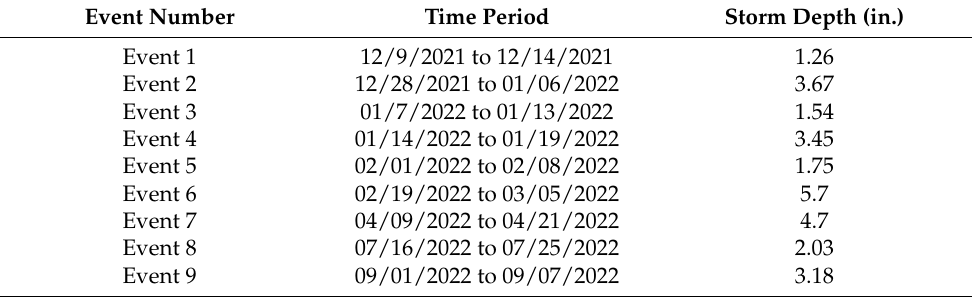
Table 2. Selected storm events for analysis. Time Period Storm Depth (in.)